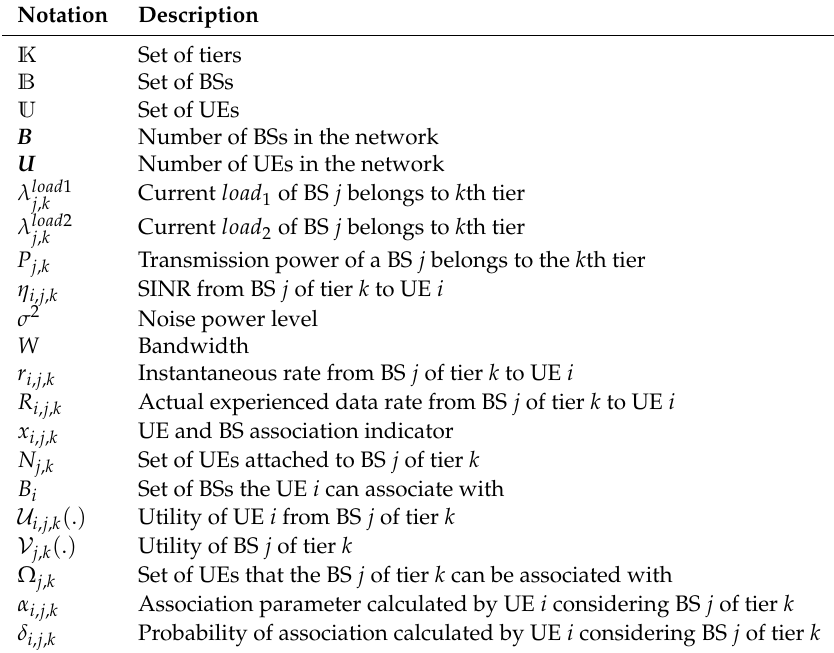
Table 2. Brief description of